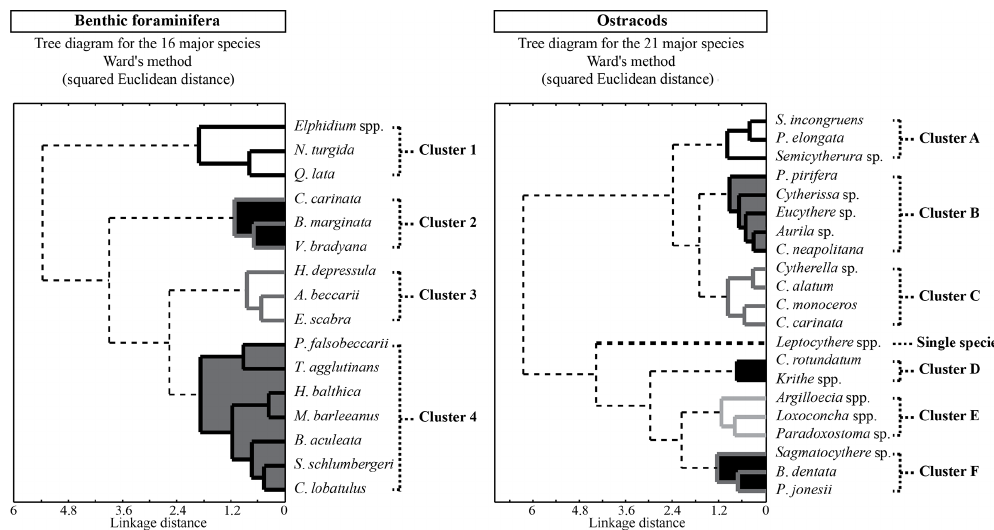
Figure 7. R-mode cluster analyses of the 16 major (more than 5% in at least one sample) benthic foraminiferal species, and of the 21 major ostracod species according to Ward’s method, based on standardized percentages pi of these